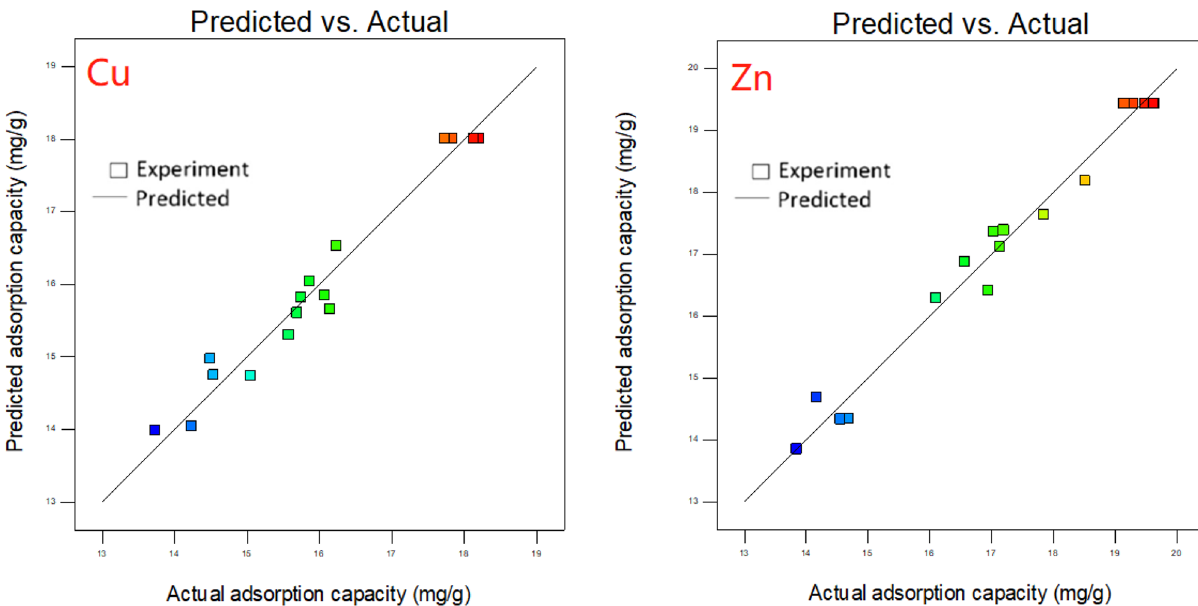
Figure 2. Predicted vs. experimental adsorption capacity of target biochars for target heavy metal